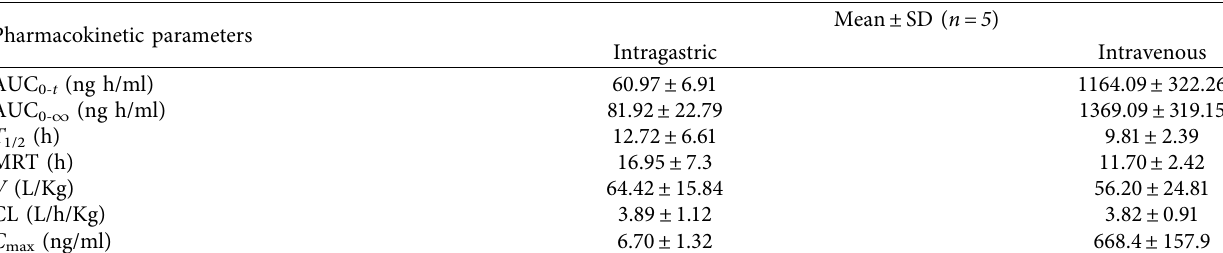
Table 7: Results of the main pharmacokinetic parameters of liensinine after intragastric administration of liensinine (5mg/kg) to rats. Pharmacokinetic parameters